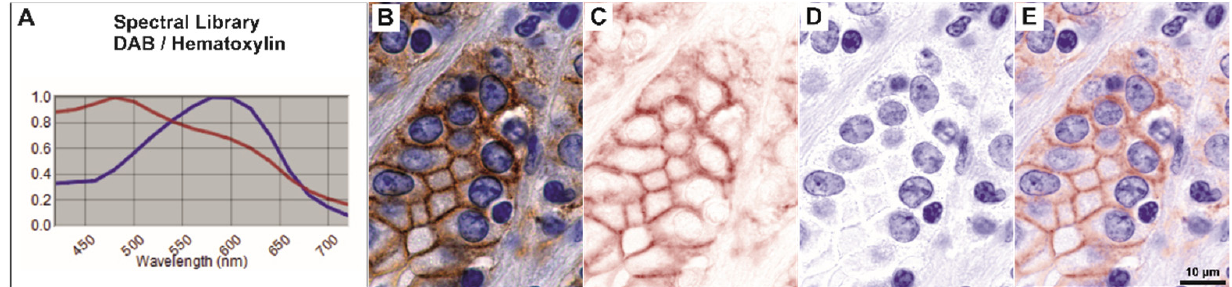
Figure 1. Example of spectral unmixing for enzymatic immunohistochemistry. ( A ) Spectral library built within the Nuance FX package in order to separate hematoxylin and DAB shows distinct emis- sion peaks. ( B ) Raw RGB exemplary image of E-cadherin immunohistochemistry, as captured by the sensor in RGB mode. ( C – E ) Correspondent unmixed images showing separate spectra for DAB and hematoxylin, as well as the merged image, clearly show membrane and sub-membrane cyto- plasmic dense-diffuse staining ( E ). Scale bar for images B–E, 10 μ m.